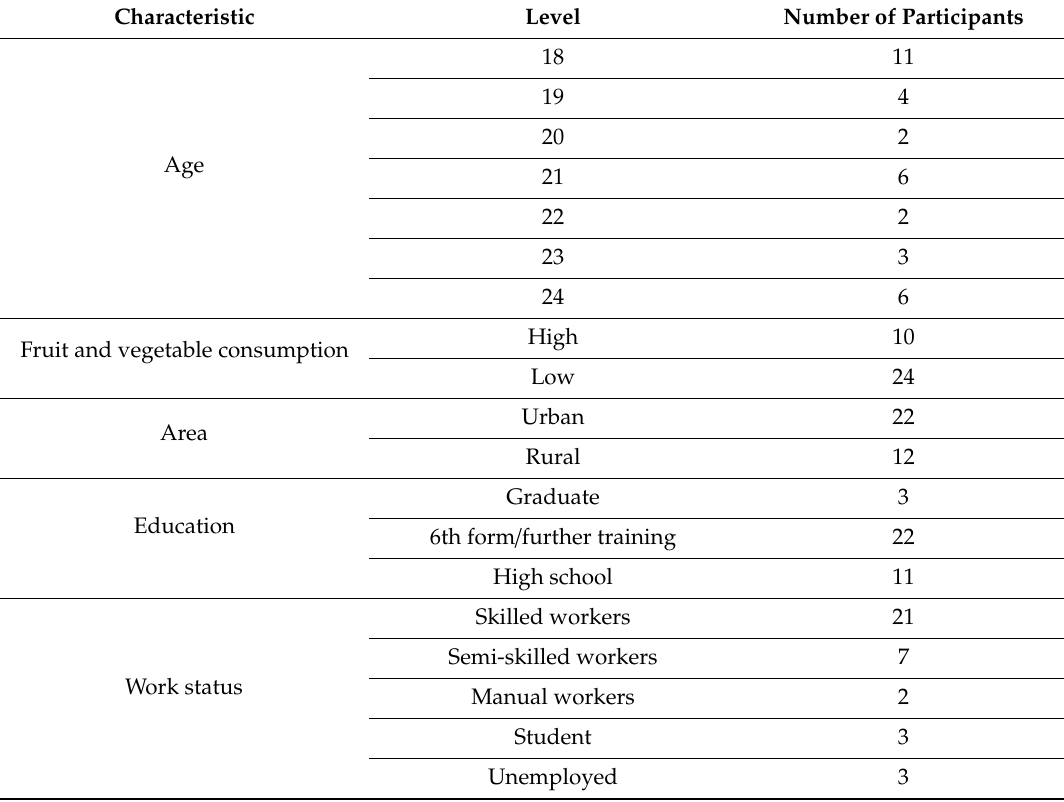
Table 1. Demographic characteristics of participants in the focus